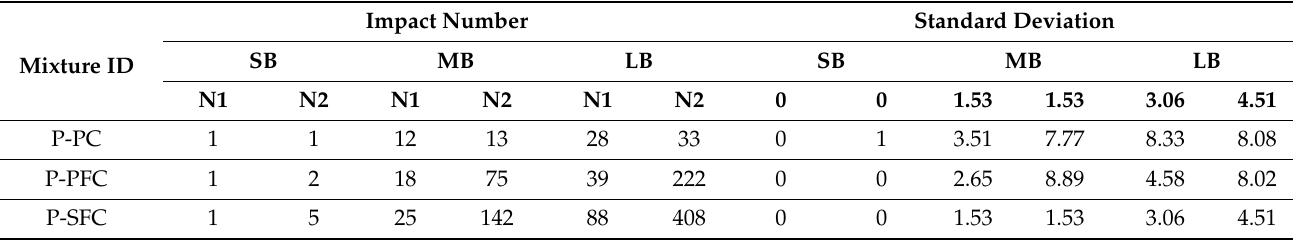
Table 2. Impact strength results of the tested beams.